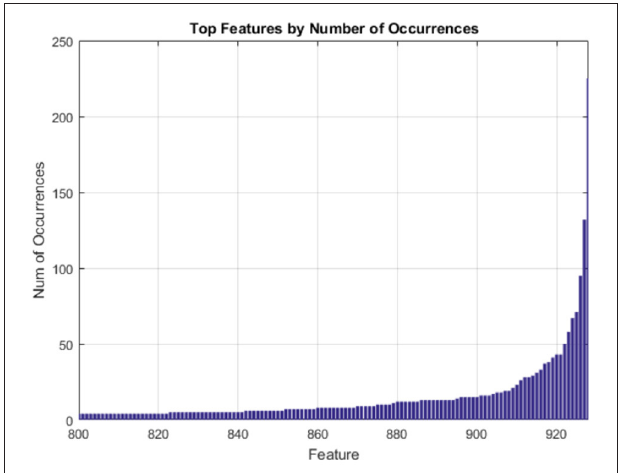
FIGURE 4 | Gene expression features ranked by frequency of occurrence over 500 randomized trials of SFFS.